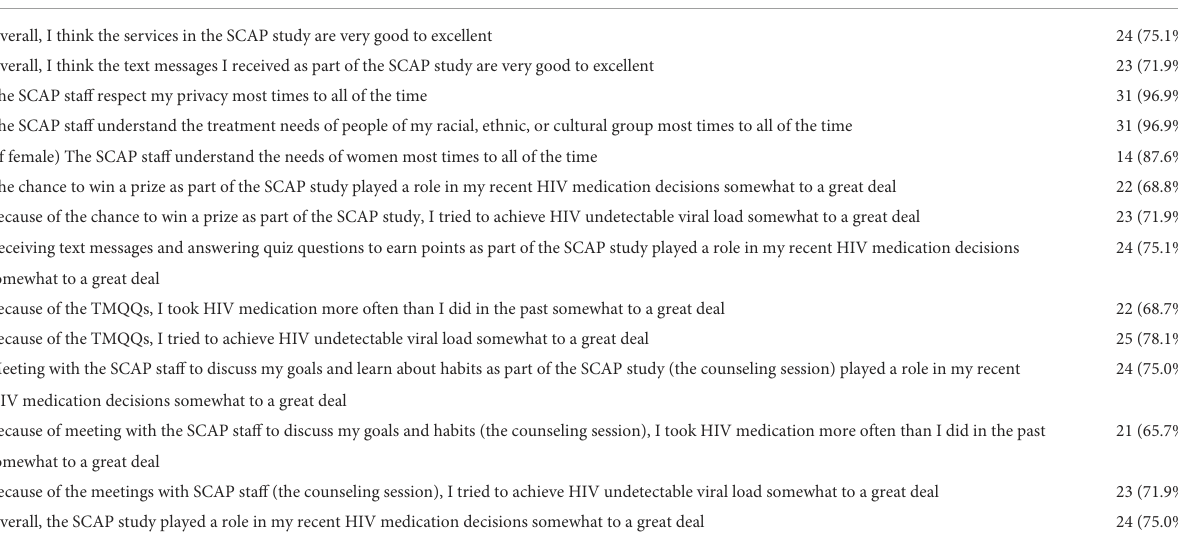
TABLE 5 Intervention acceptability at the final follow-up assessment ( N =